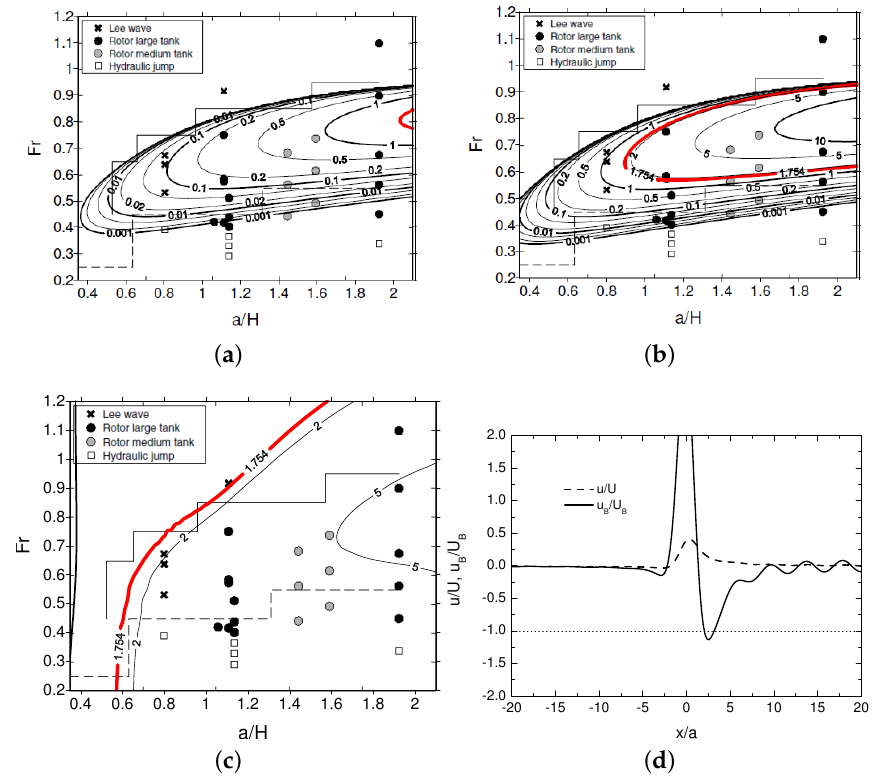
Figure 7. ( a – c ) Inverse of the critical dimensionless mountain height [( h 0 / a ) crit ] − 1 as a function of a / H and Fr for l 2 a = 1.426, superposed on KEPE10’s regime diagram (adapted from Figure 9 of KEPE10). Contours: 5, 2, 1, 0.5, 0.2, 0.1, and so on. The contour of 1.754 is denoted by a thick red line. ( a ) Inviscid model Equation (25); ( b ) improved model Equation (26); ( c ) full model; ( d ) u / U and u B / U B as a function of x / a for l 2 a = 1.426, Fr = 0.64, a / H =